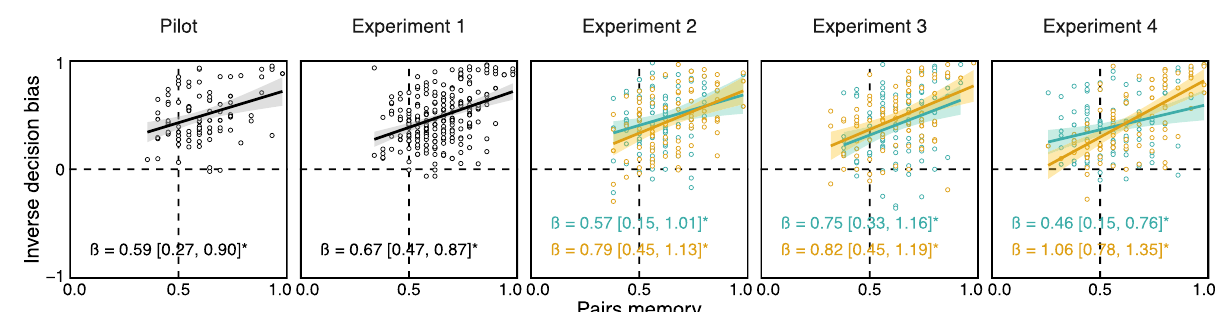
Fig. 4 Replicating the main effects across fi ve distinct data sets. Experiment 1 ( n = 235) was pre-registered on Open Science Framework (https://osf.io/ chsvw) following a Pilot study ( n = 93). Experiments 2 to 4 include different experimental manipulations of the Deliberation phase (depicted by yellow and cyan colors). We manipulated the number of times each deliberation pair was presented (Experiment 2, memory manipulation, n = 96), the magnitude of potential gains (Experiment 3, motivation manipulation, n = 95), and the high-level association of pairs by assigning some of them as belonging to the same painter (Experiment 4, binding manipulation, n = 93). a The tendency to select rewarded paintings for chosen pairs (S chosen + ), but unrewarded ones for unchosen pairs (S unchosen 0) was replicated across conditions. b Memory of the deliberation pairs was related to inverse decision bias (difference in decision tendency of chosen and unchosen pairs) in all experiments and conditions. Points denote trial-averaged data of individual participants. In panel ( a ), error bars denote standard error of the mean. In panel ( b ), betas represent the memory slope coef fi cients in a Bayesian linear regression predicting inverse decision bias as a function of memory accuracy, and for both betas and model fi ts we show median and 95% highest-density intervals of the corresponding posterior distribution. S + denotes a rewarded stimulus (for unchosen stimuli, this is the outcome of their chosen counterpart). Source data are provided as a Source Data fi